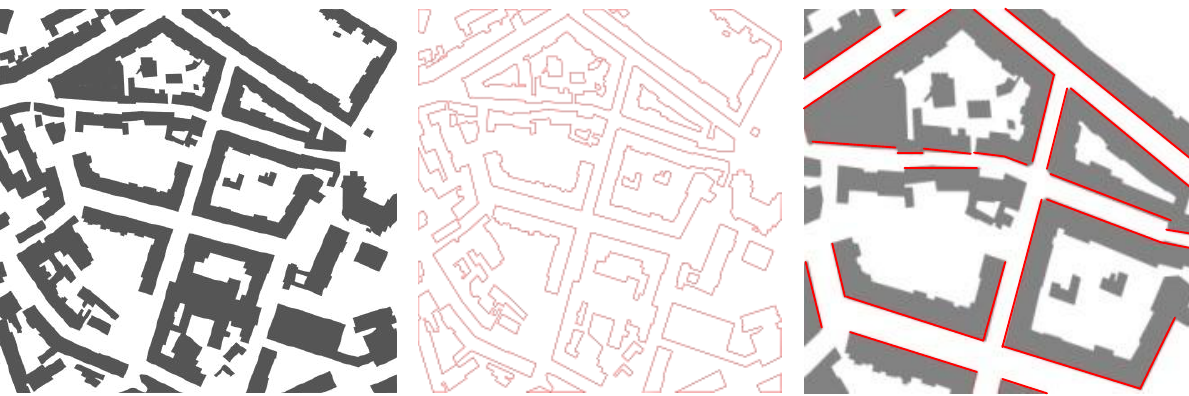
Figure 4. The classification layer “ building ” is based on color, texture and elevation values. (a) is the binary layer; (b) presents the contours as a raster image and (c) are the detected façade footprints highlighted in